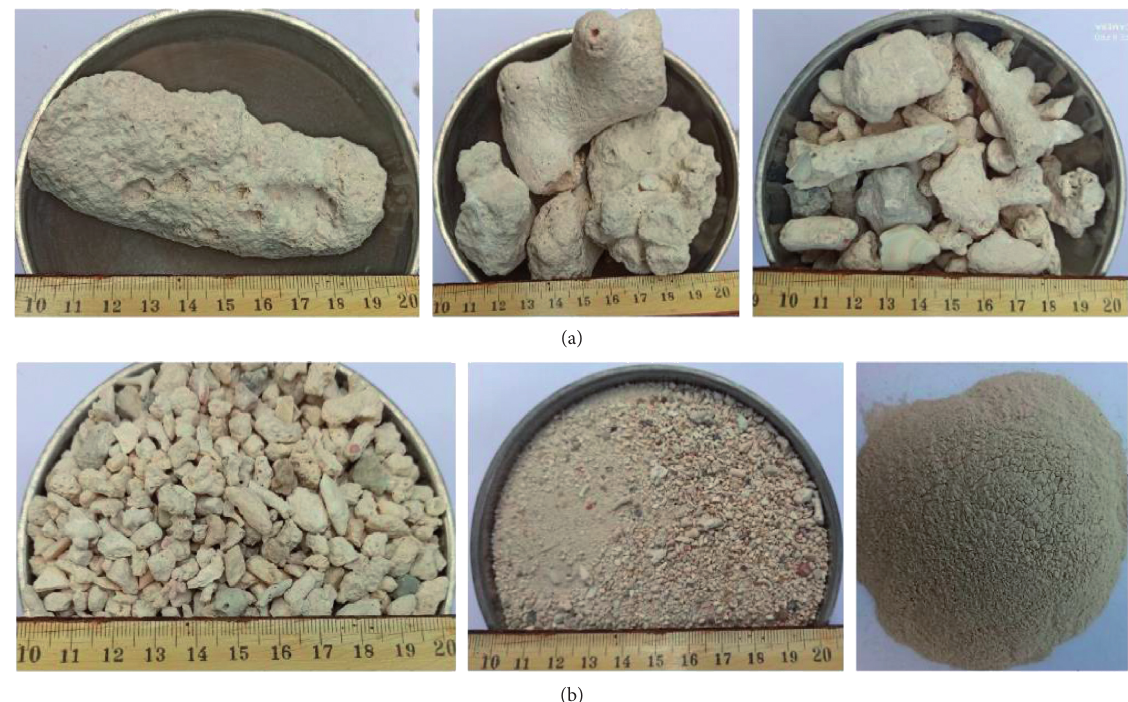
Figure 1: Calcareous sand samples with different particle sizes (mm).